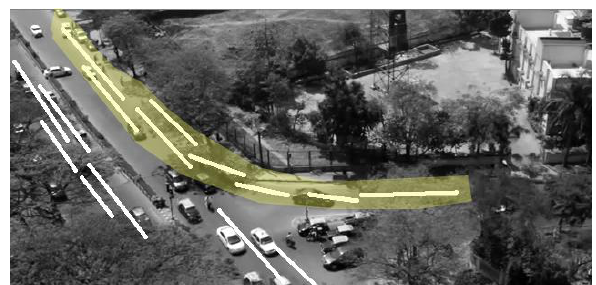
Figure ６ : Trajectories in the Road Junctions Tend to Form Incorrect Clusters